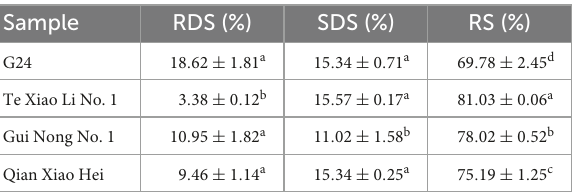
TABLE 3 The in vitro starch digestibility of adzuki beans.